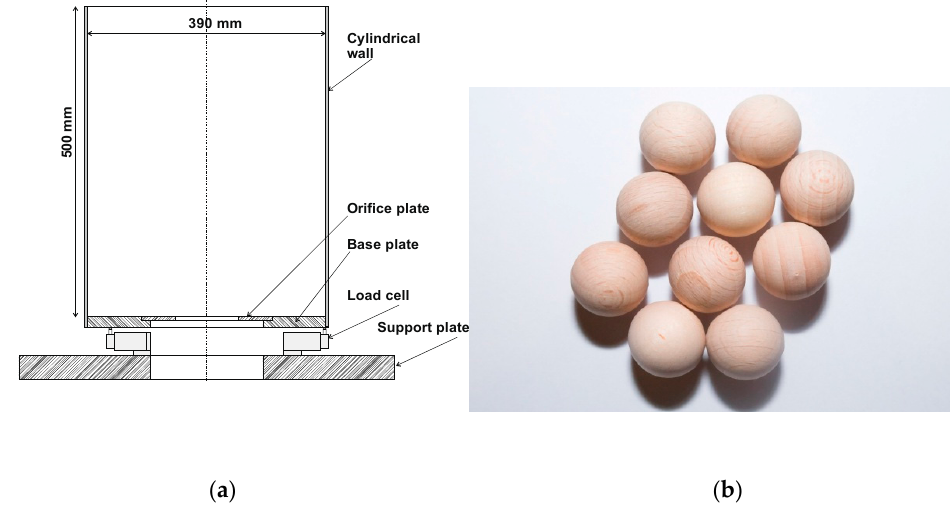
Figure 1. Scheme of the model bin with load cells attached ( a ), and real view of typical particle used in experiment ( b